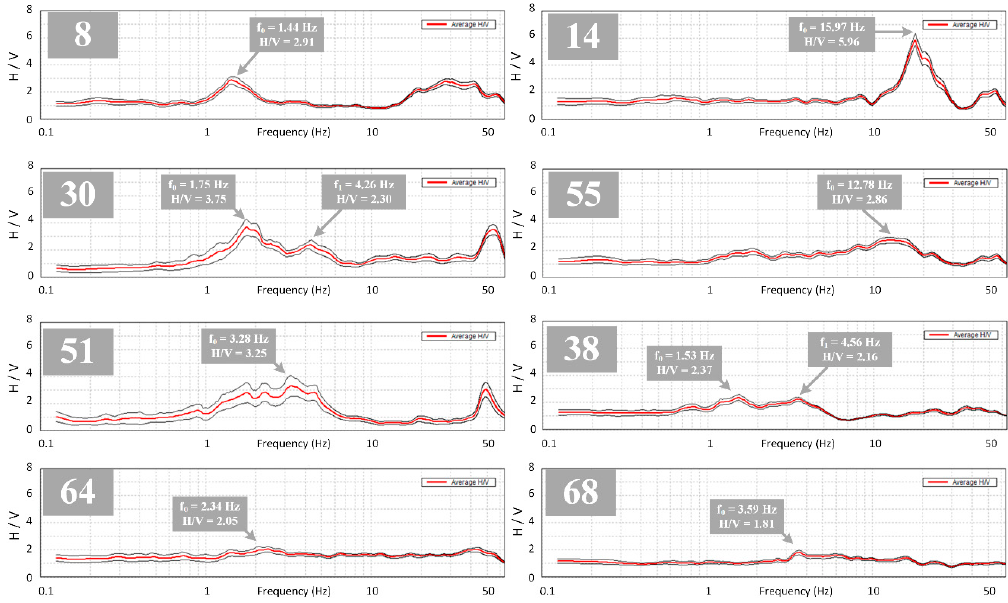
Figure 5. Selected examples of HVSR curves showing clear (8, 14), broad (51, 55) and multiple peaks (30, 38) with examples of flat HVSR curves that show small peak (64, 68). The average HVSR plot is represented by a thick red line and fundamental frequencies are marked with grey arrow. Black thin lines indicate the 95 % confidence interval of the HVSR.